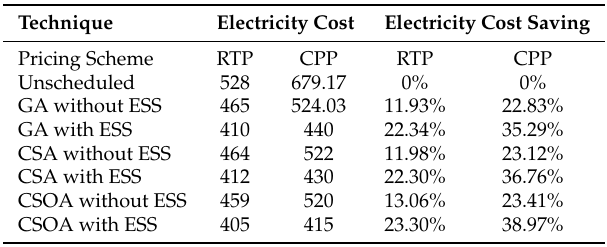
Table 6. Summary of the results for a single smart